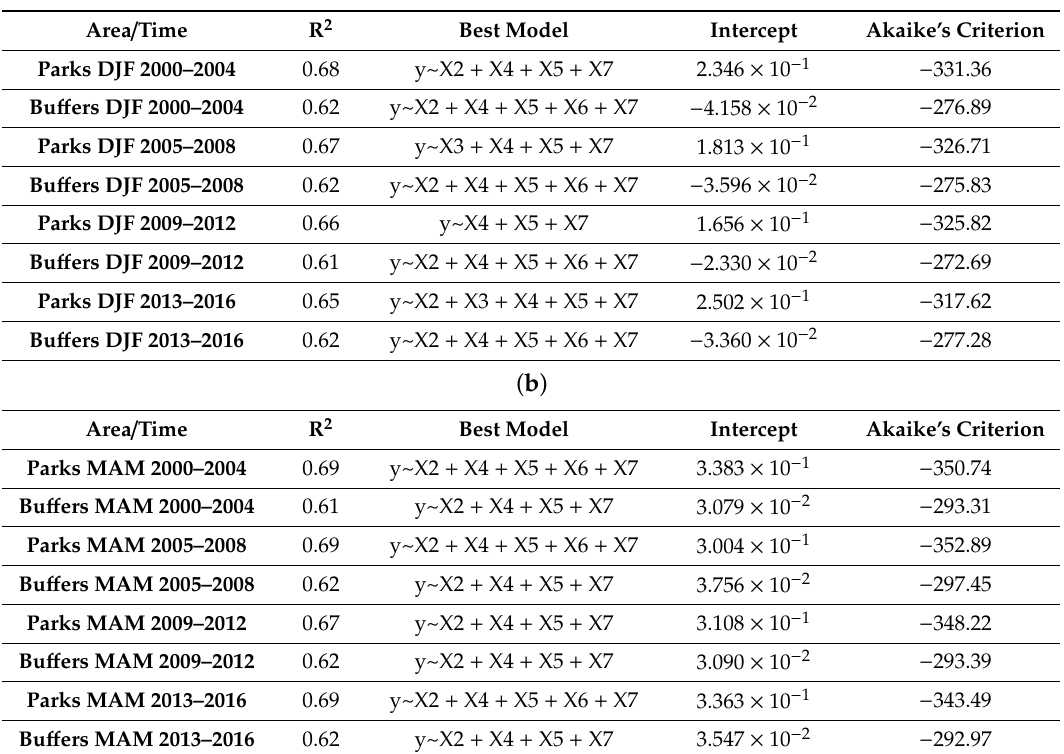
Table 1. Stepwise backward regression results including the best model, intercept, and Akaike in ( a ) December, January and ( b ) February, March, April, and May. The independent variables in these regressions were: country (X1), land cover (X2), area (X3), mean annual precipitation (X4), human population (X5), elevation (X6), and transfrontier (X7 and n = 31 of the 79 parks). ( a ) Area / Time R 2 Best